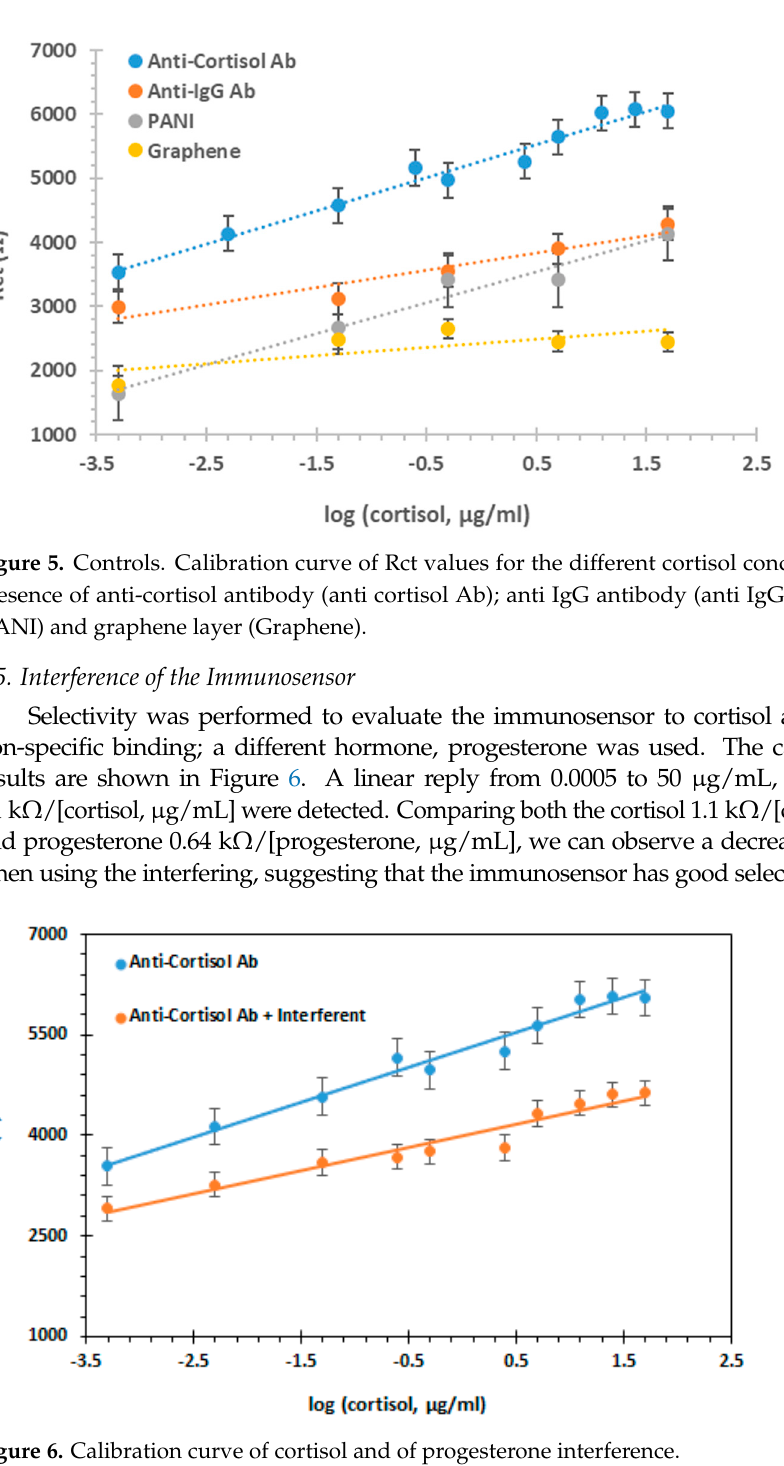
11 of 15 Figure 4. ( A ) CV of control, PANI, antibody and BSA; ( B ) Nyquist plots of control, PANI, anti-cortisol and BSA; ( C ) Nyquist plots for different concentrations of cortisol; ( D ) Calibration curve of R ct values for the different cortisol concen- trations.